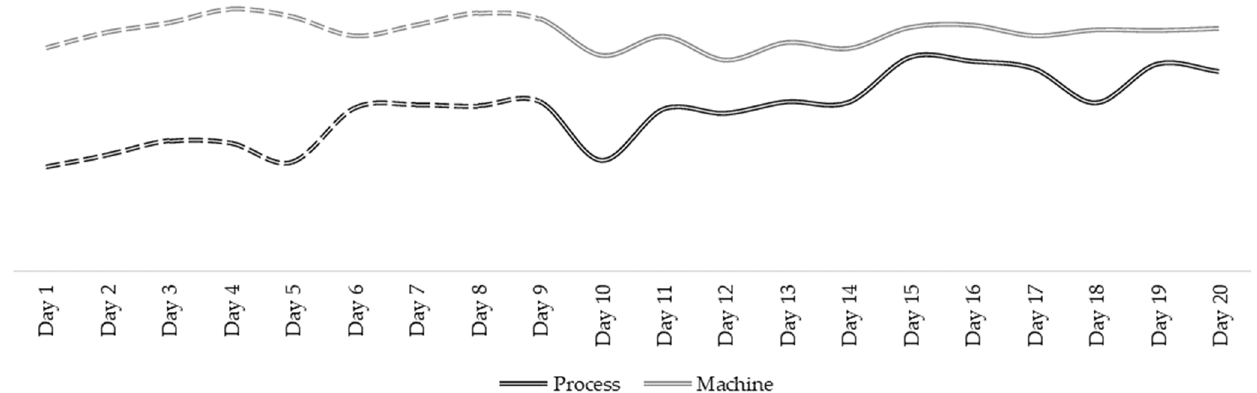
Figure 5. Quality rate trend for the semi-automatic packaging